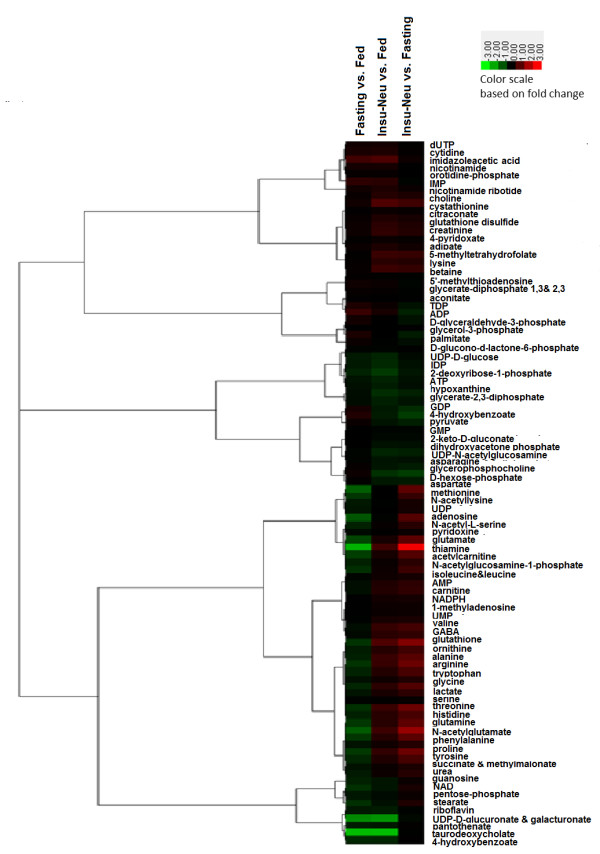
Heat map of metabolites. The median value of each metabolite in each treatment group was used to calculate fold-change of fasted vs. fed, insulin-neutralized (insneut) vs. fed, and insulin-neutralized vs. fasted, and then values were subjected to hierarchical clustering.